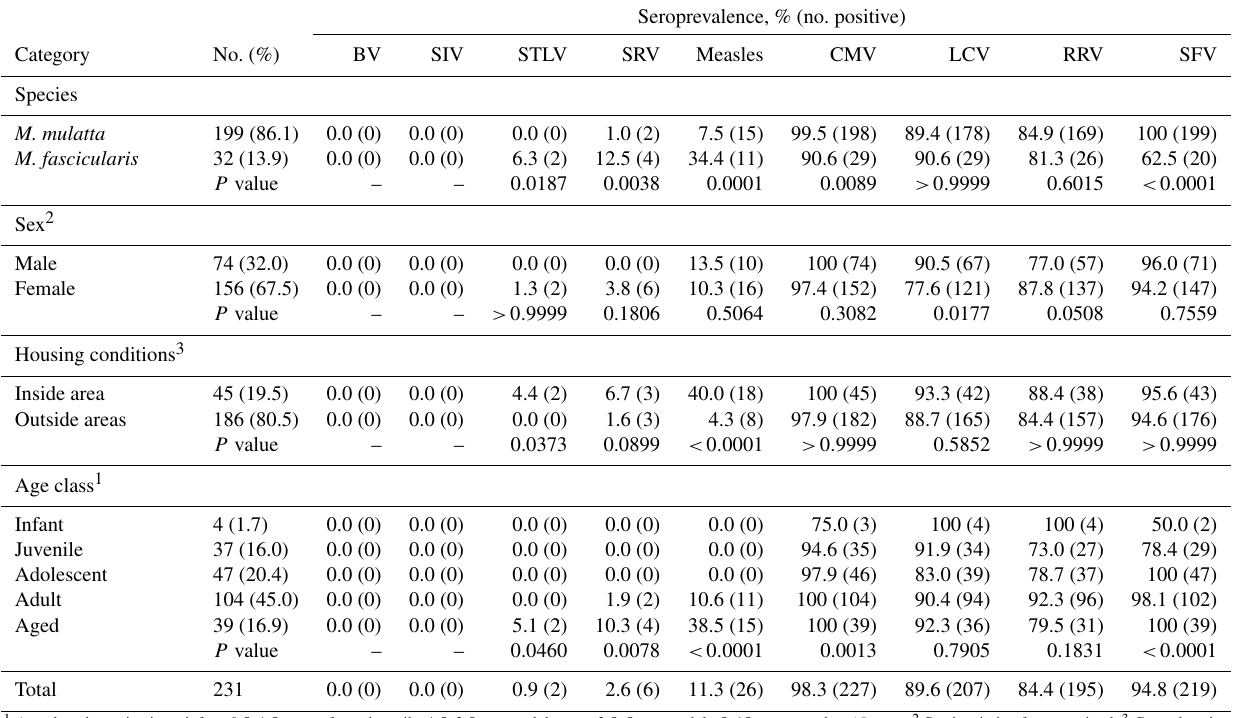
Seroprevalence, % (no.